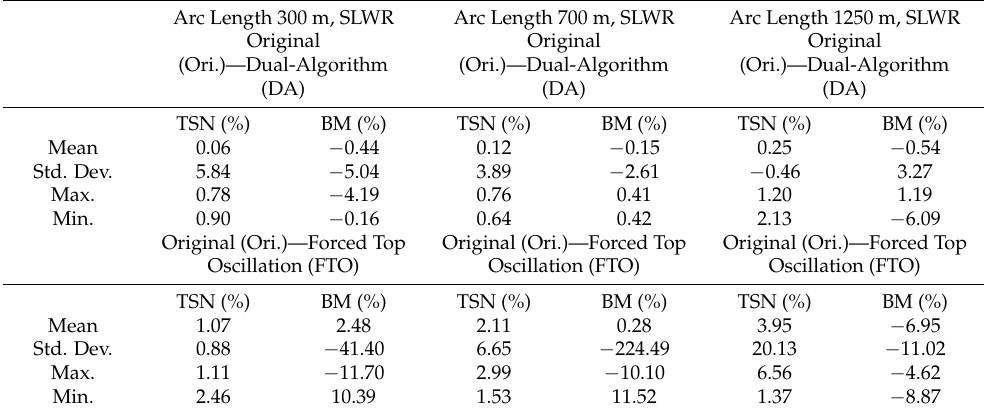
Table A4. Error Comparison between Original vs. Dual-Algorithm (DA) or FTO, 100-yr storm, WD1000,